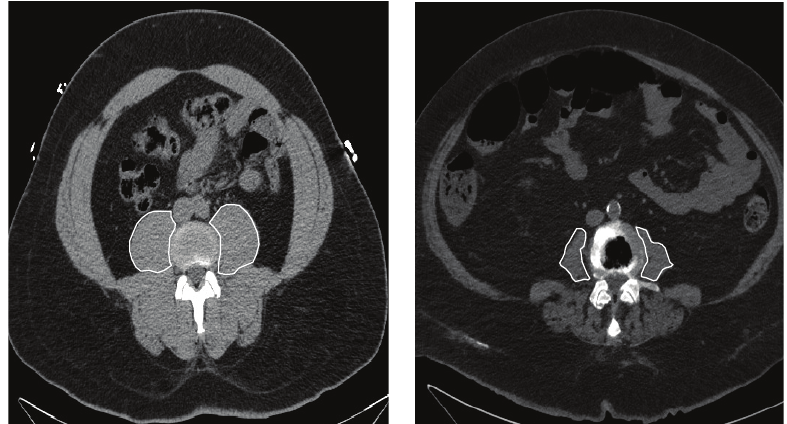
Figure 1: Example calculation method for TPA based on axial CT scan at L3 in two patients. Notice the difference in TPA between them.